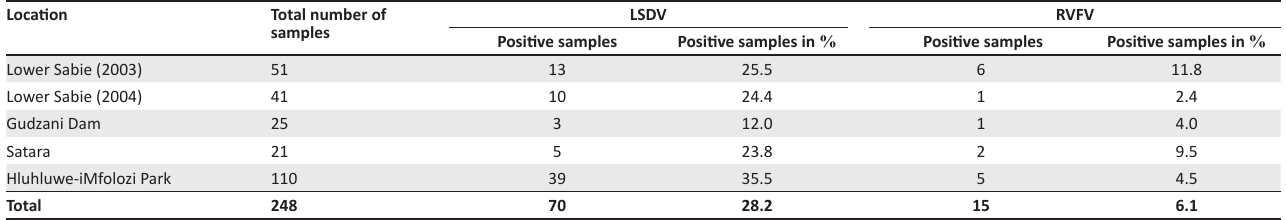
TABLE 2: Indirect ELISA results for lumpy skin disease virus and Rift Valley fever virus.